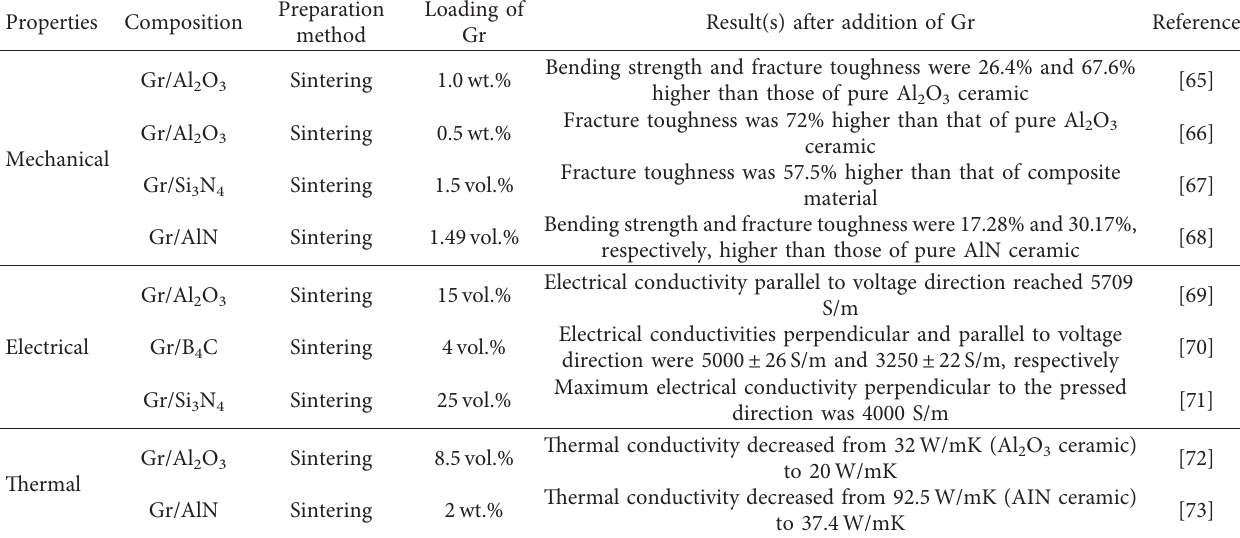
Table 4: Properties and preparation methods of graphene/ceramic composite